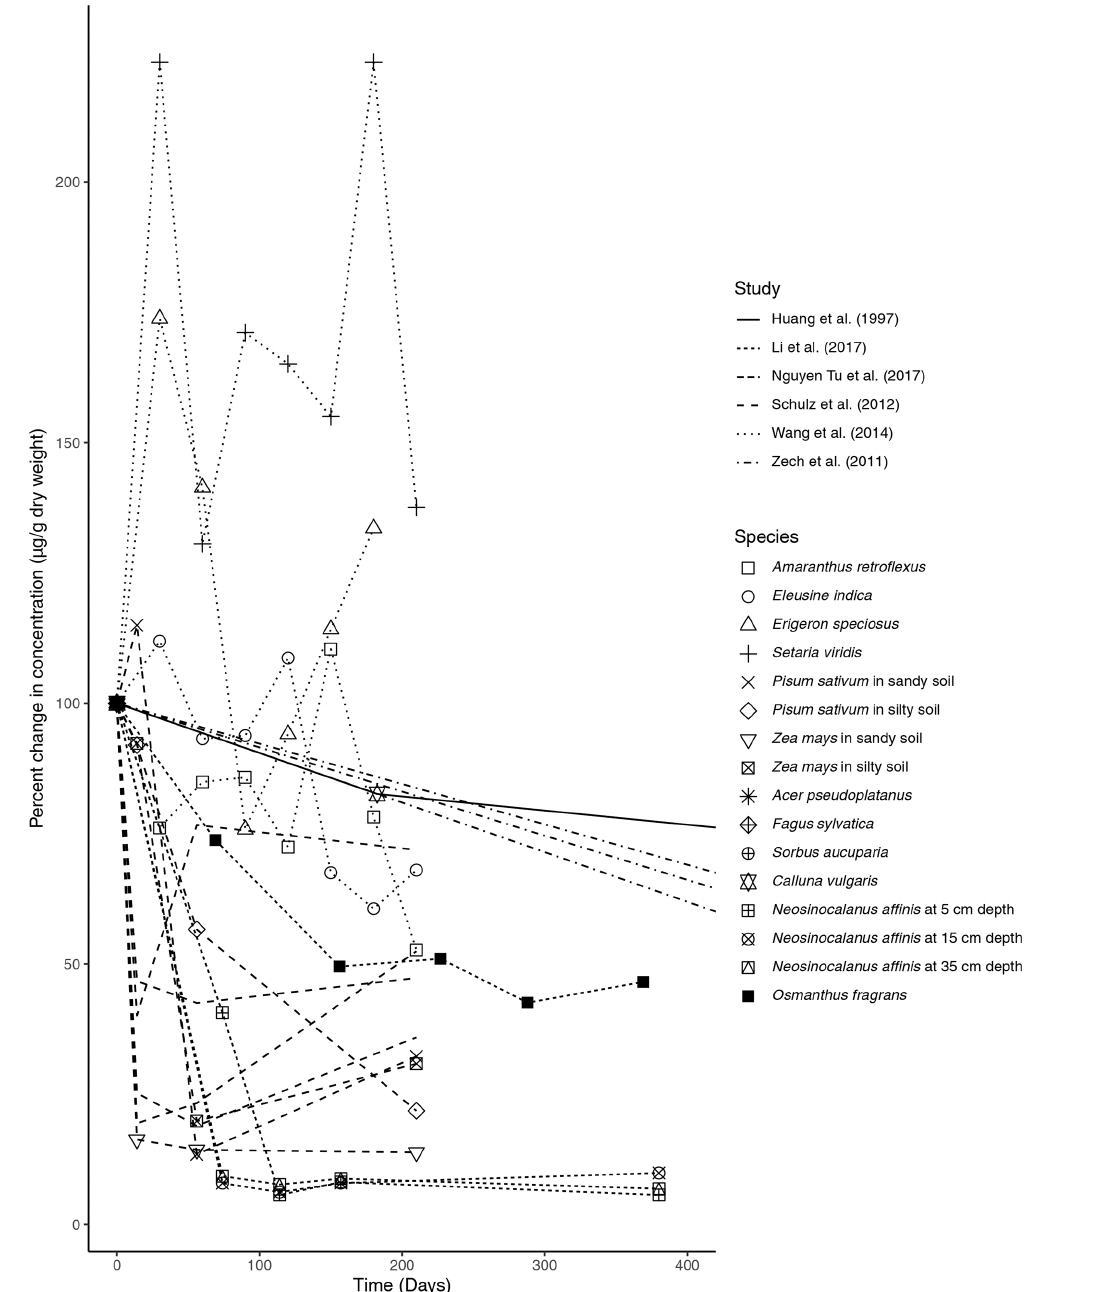
Figure 1. Percent change in concentration (µg/g dry weight) of n -alkanes over time in litterbag